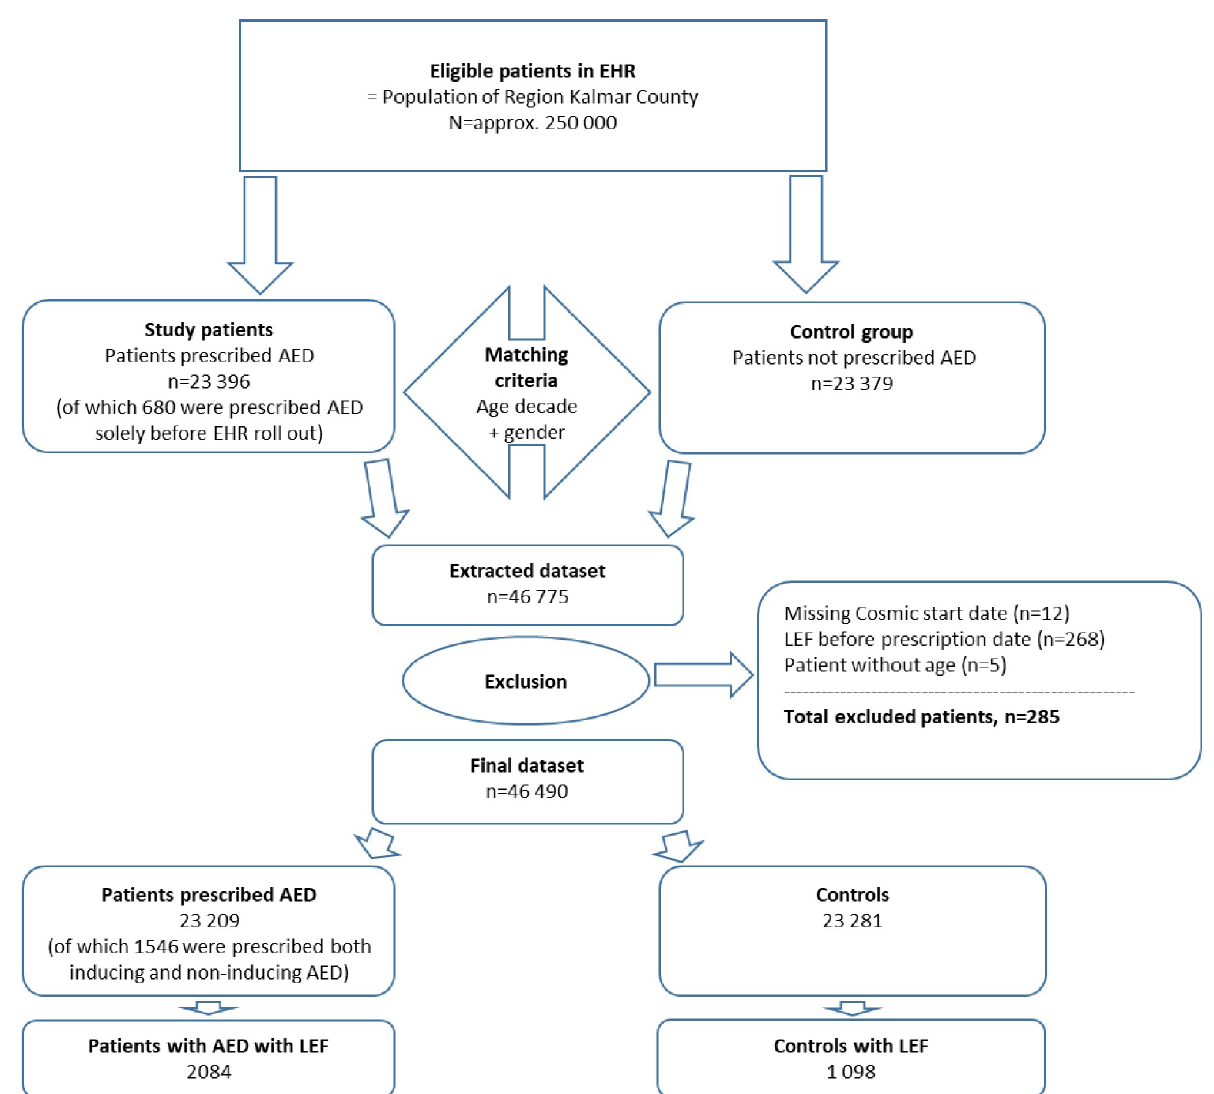
Fig 1. Flowchart for patient and control group inclusion and primary outcome. G41 (Status epilepticus) or F803 (Acquired aphasia-epilepsy syndrome). Diagnoses registered by